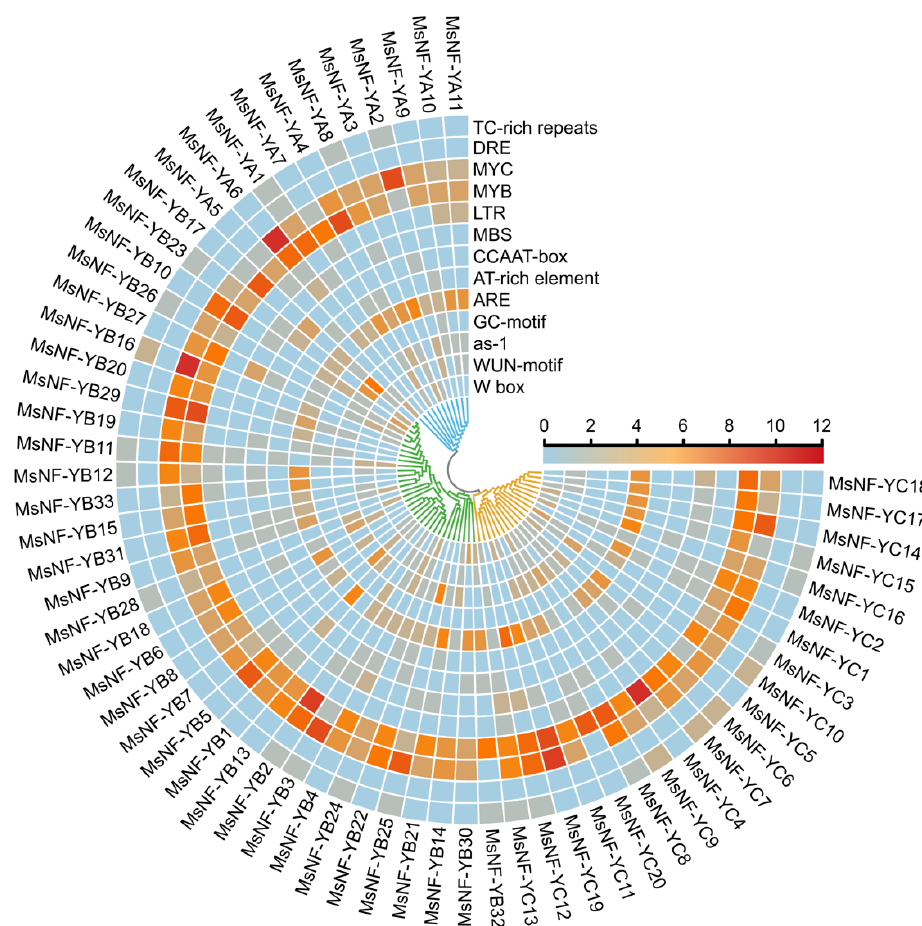
Figure 4. Cis-acting elements analysis of the promoter region of MsNF-Y genes. The cis-elements located in the ~2000 bp promoter sequence (upstream of the start codon) of all NF-Y s were analyzed via the PlantCare website. The color indicates the quantity of cis-acting elements (details shown in File S4).